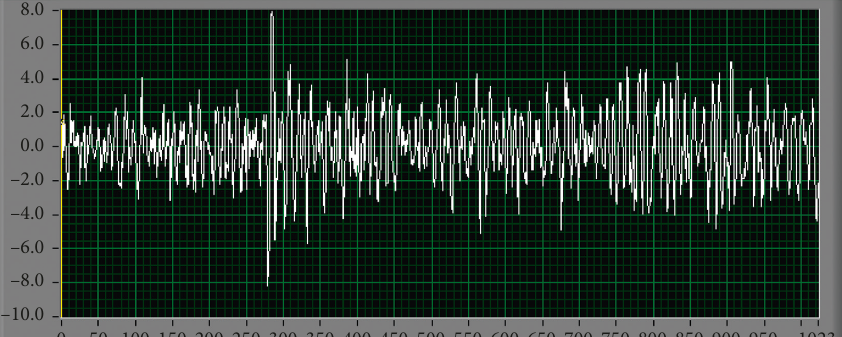
Figure 6: Vibration image in an outer wear